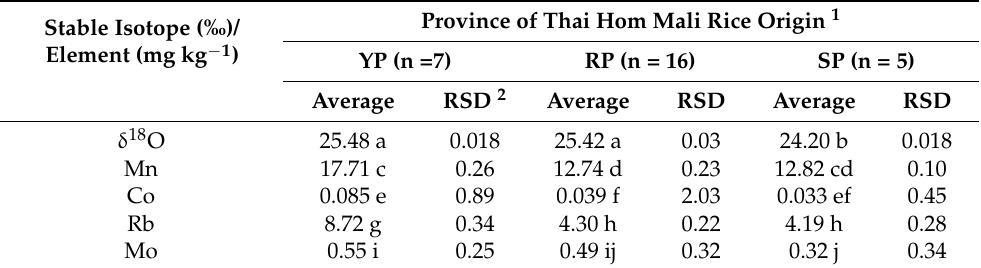
Table 1. Stable isotope and elements in THMR samples cultivated in three contiguous provinces. Stable Isotope (‰)/